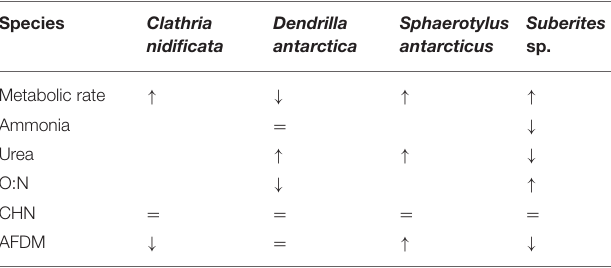
TABLE 4 | Summary of seasonal differences in physiological metrics for Clathria nidificata , Dendrilla antarcticus , Sphaerotylus antarcticus, and Suberites